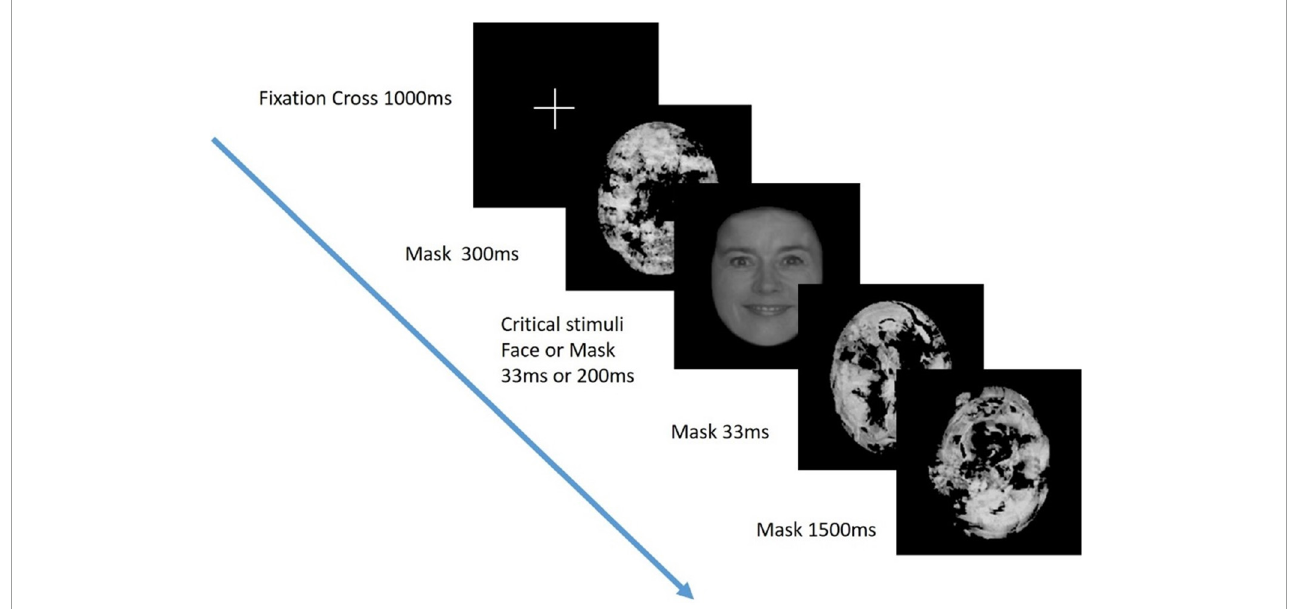
FIGURE1 Visual perception task. Critical stimuli (either a face or mask), were presented at either 33 ms or 200 ms duration in a visual masking paradigm adapted from Kouider et al. (2013). Previous studies have demonstrated that stimuli presented at 200 ms but not 33 ms are consciously